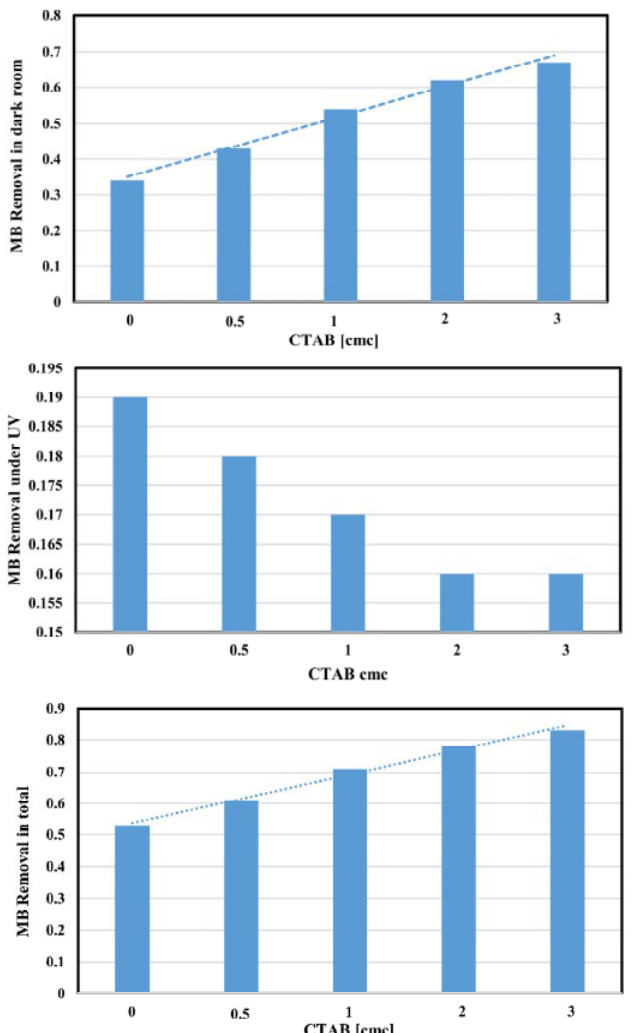
Fig. 7. (a) Adsorption, (b) photocatalytic behavior & (c) dye removal of the synthesized ZnS porous specimens from different CMC values of CTAB